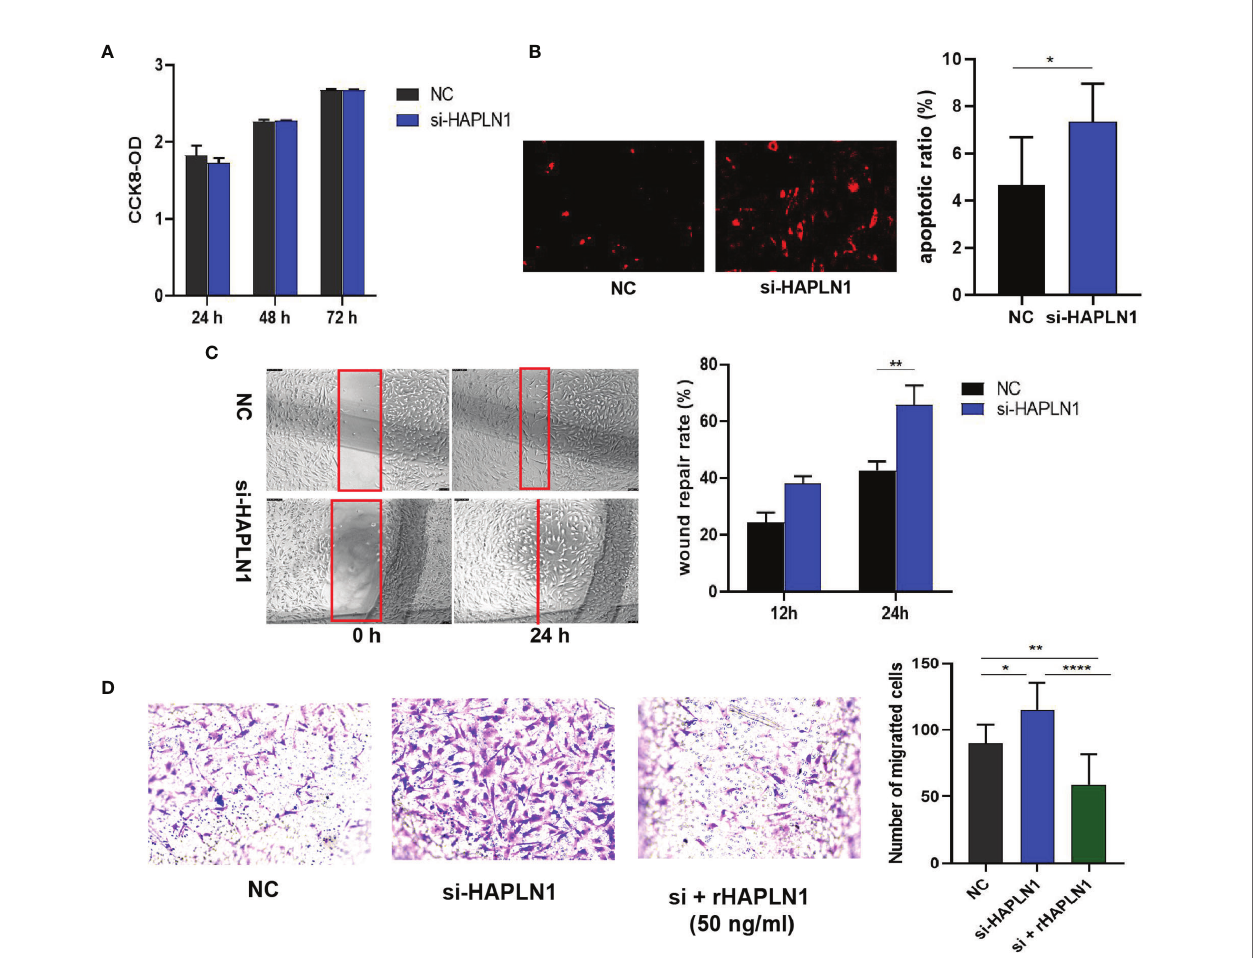
FIGURE 2 | Effects of si-HAPLN1 on RA-FLS activity. Transfection of siHAPLN1 in RA-FLSs did not signi fi cantly affect the (A) proliferation but signi fi cantly increased (B) apoptosis (magni fi cation: 10×10) and (C, D) migration ability of RA-FLSs. Wound healing (C , magni fi cation: 10×5 ) and transwell assays (D , magni fi cation: 10×5 ) were used to measure the migration capacity of FLSs. Recombinant HAPLN1 (50 ng/ml) attenuated the increased migration ability induced by si-HAPLN1 in the transwell assay. *p < 0.05; * *p < 0.01; *** *p < 0.0001. NC, negative control is control siRNA of